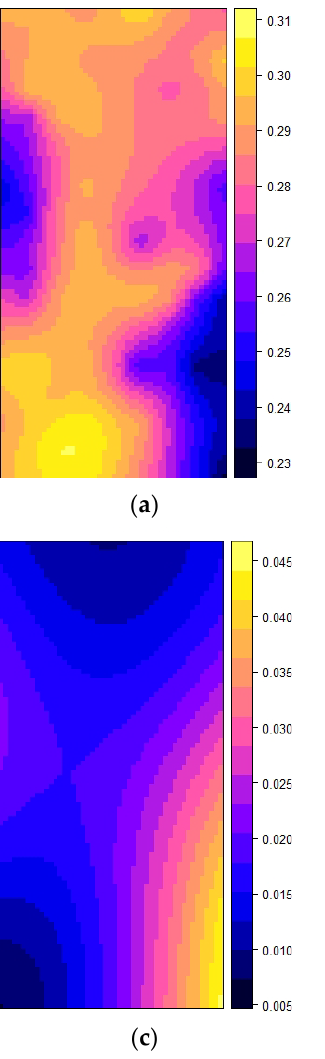
Figure 3. Maps of the interpolated values of PAWCe ( a ), RFCe ( b ), PMACe ( c ), ACe ( d ).